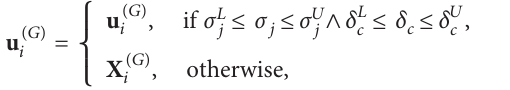
Figure 1: Adaptive mutation factor